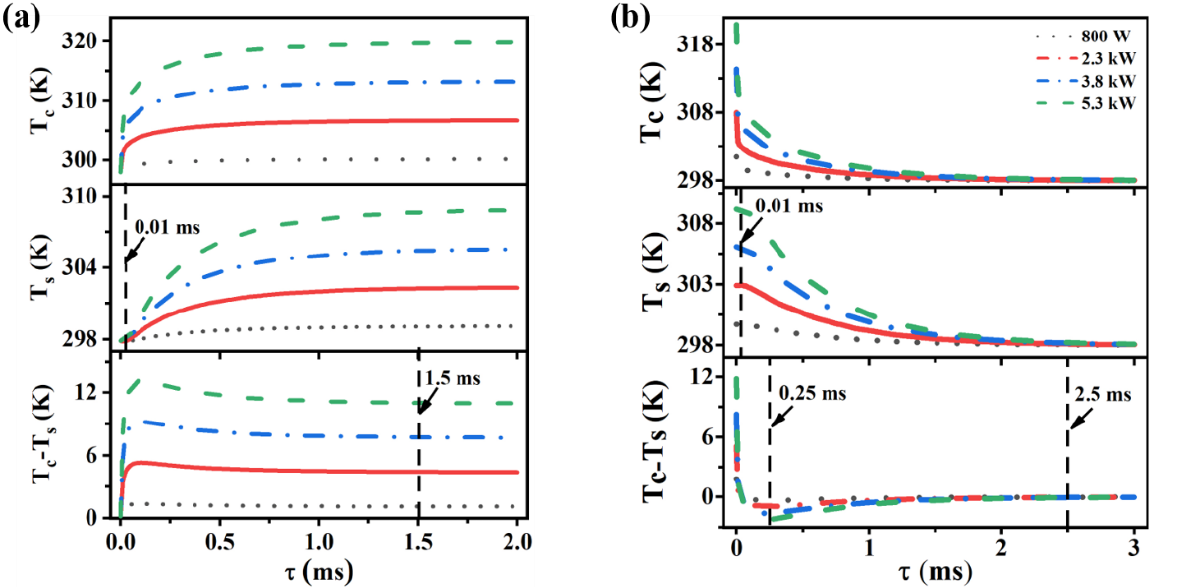
Figure 4. Transient temperature variation of diamond crystal at different pumping power levels during ( a ) heating and ( b ) cooling.